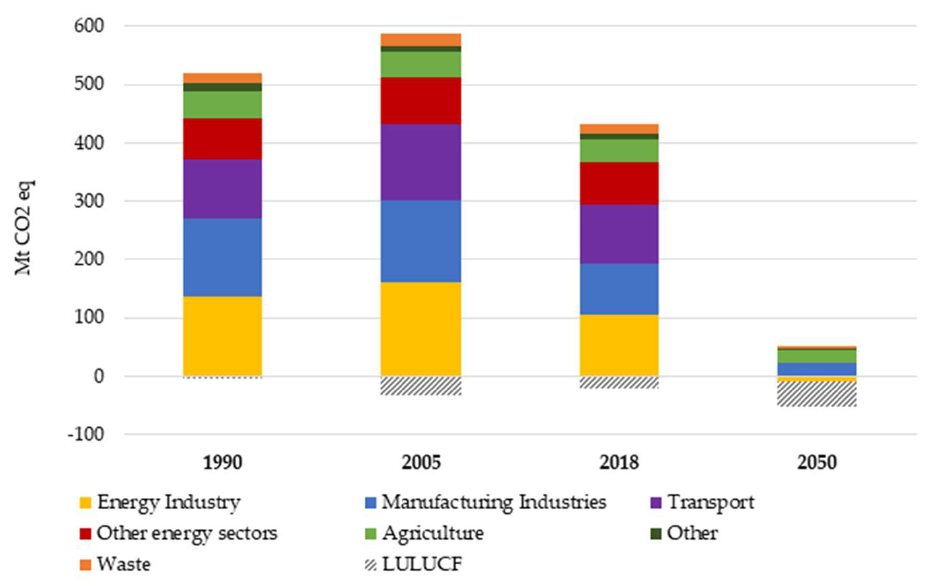
Figure 2. Greenhouse gas emissions and removal in I-LTS; Mt CO 2 eq [25].